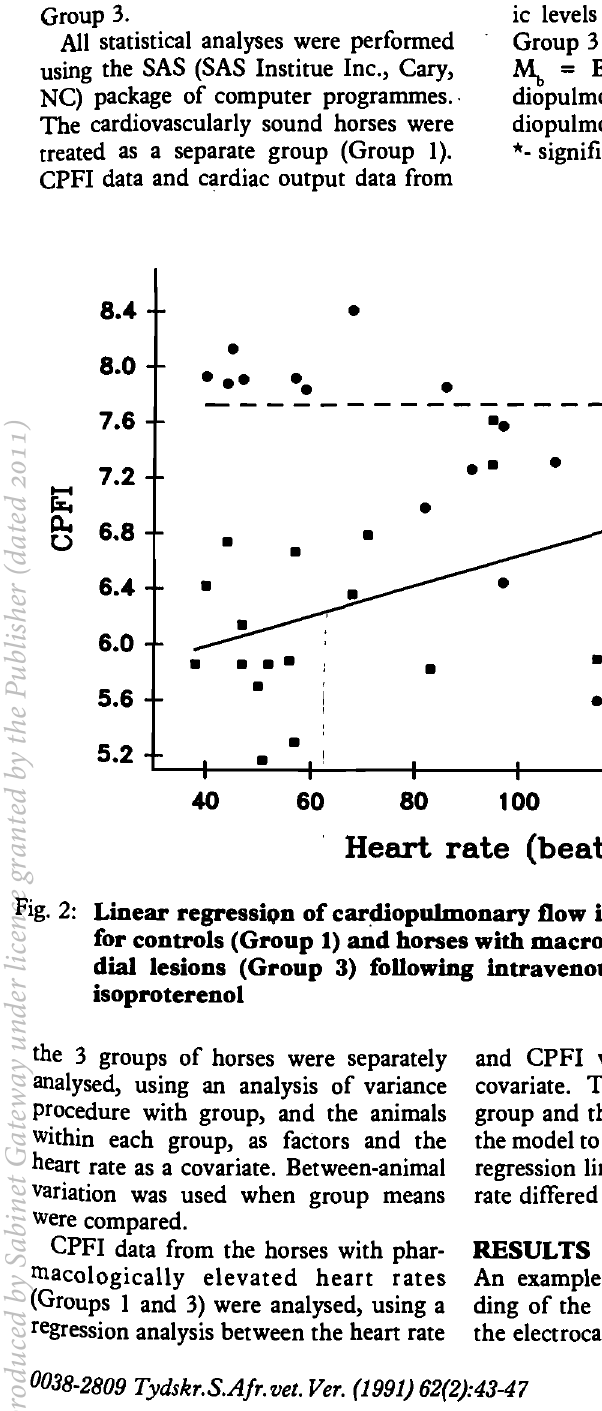
Table I: Mean (± SD) and number of observations (n) for age, mass, car diac output, cardiac index, cardiopulmonary flow index, heart rate, stroke volume and cardiopulmonary blood v()lume in con " trol horses and horses probably exposed to feed contaminated with toxic levels of salinomycin- Variable